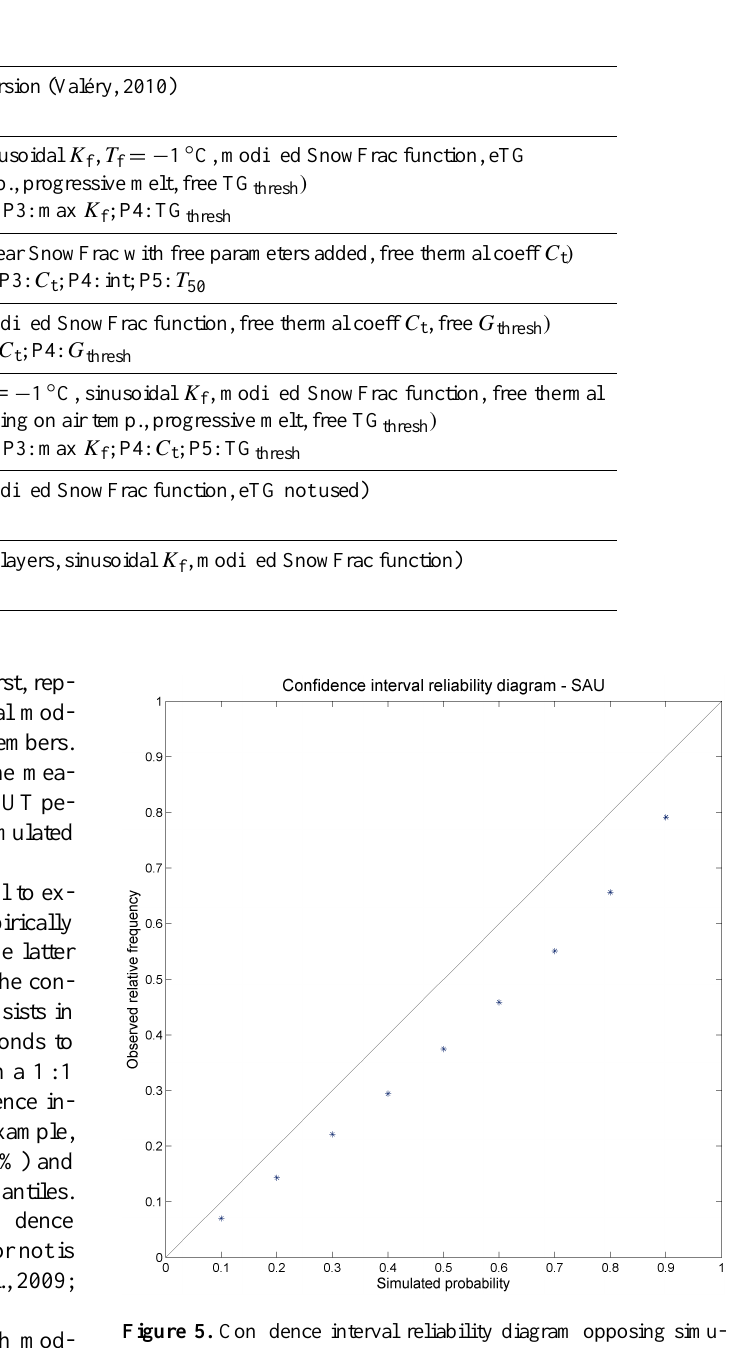
Figure 5. Confidence interval reliability diagram opposing simu- lated probability ( x axis) and observed relative frequency ( y